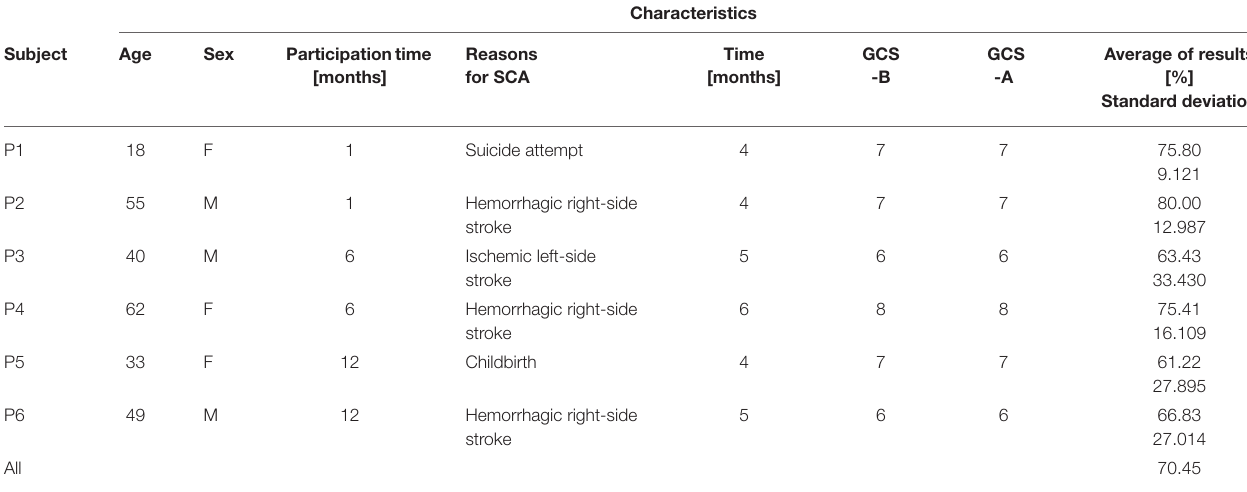
TABLE 1 | Characteristics of the sample.